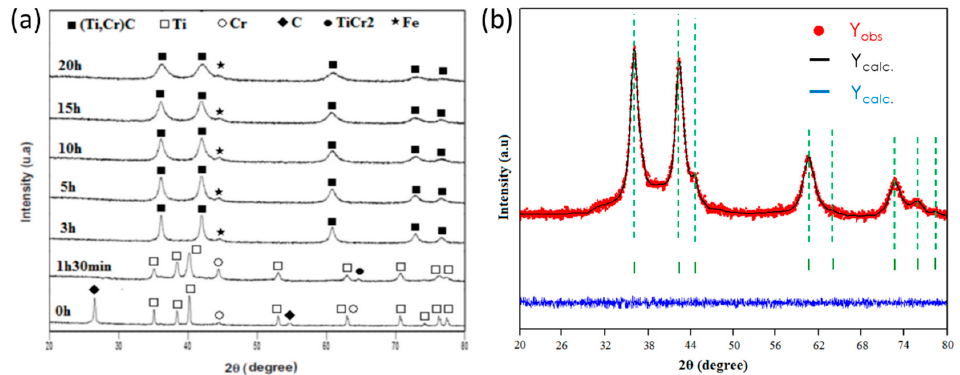
Figure 2. XRD patterns of samples prepared by MA for different milling times ( a ). Rietveld refinement plot of the sample milled for 20 h ( b